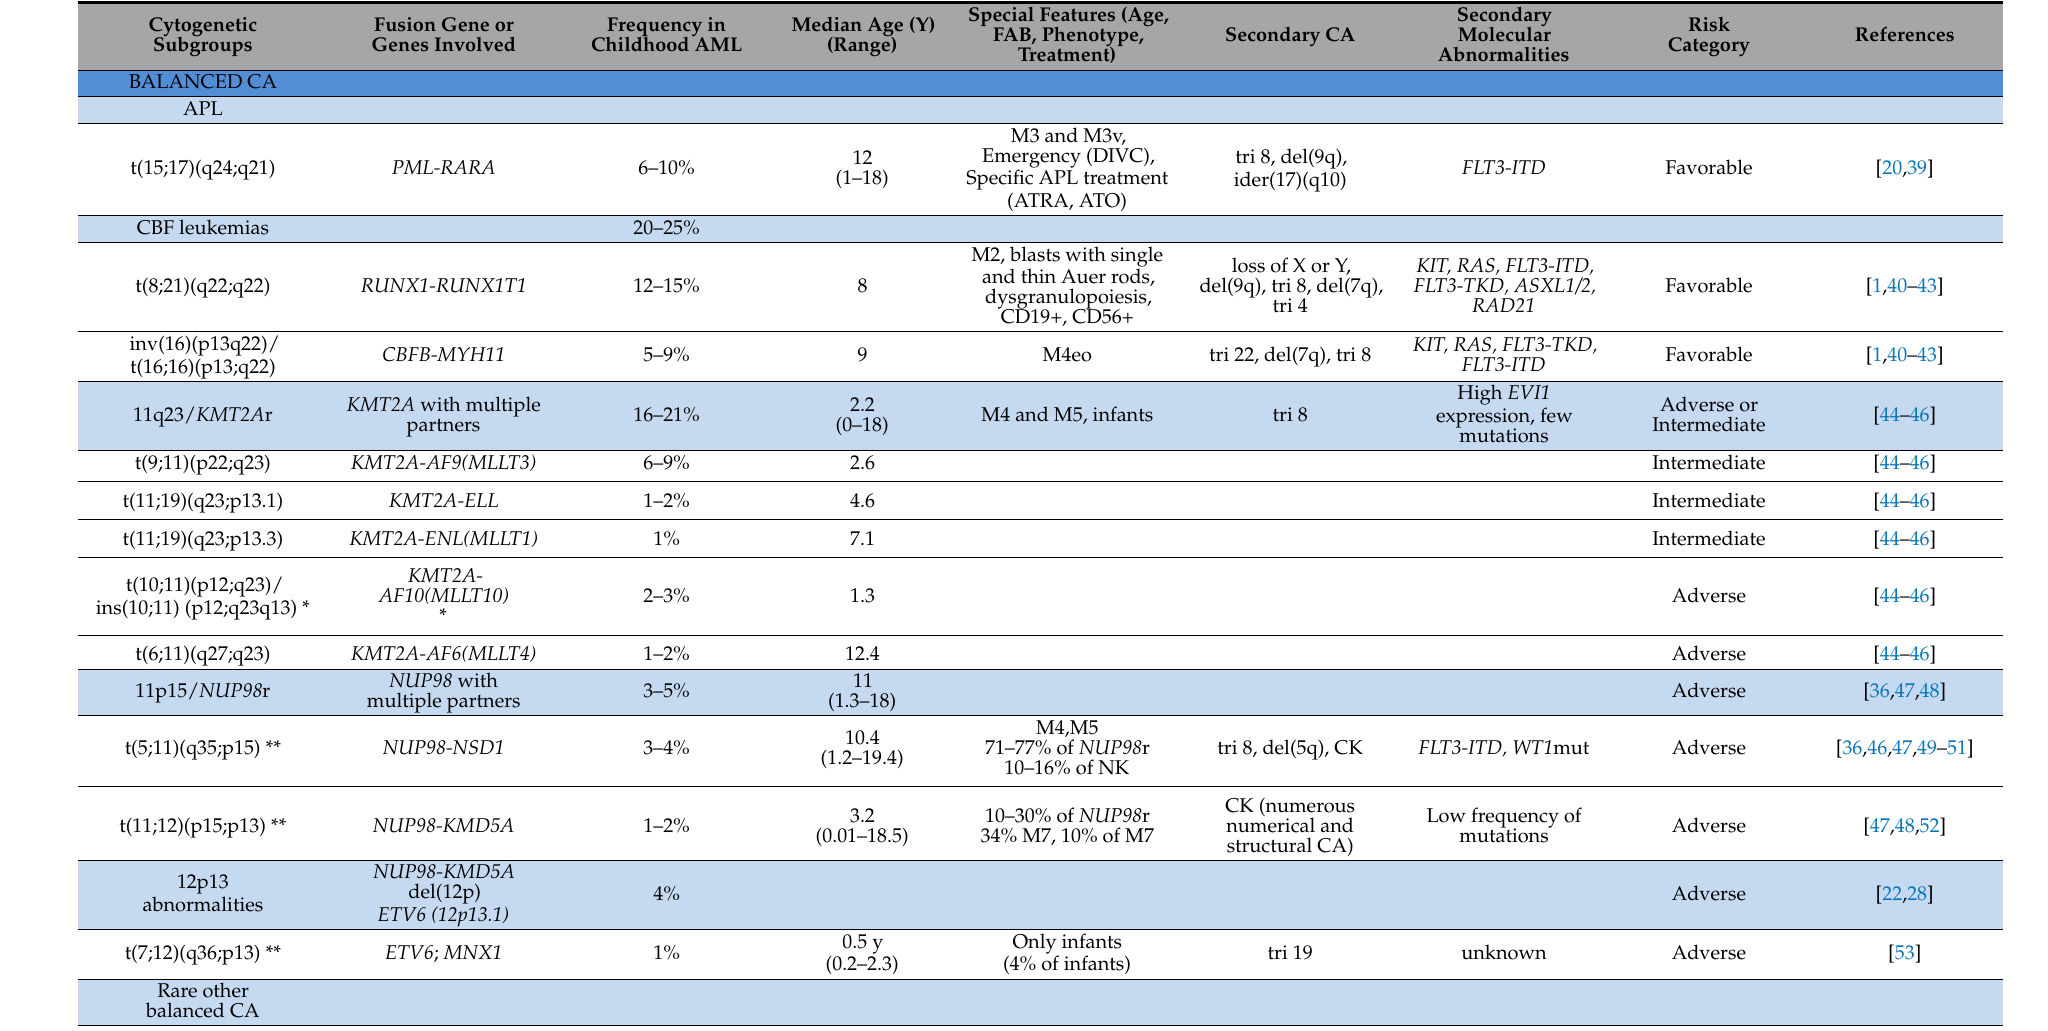
Table 1. Main cytogenetic subgroups in pediatric